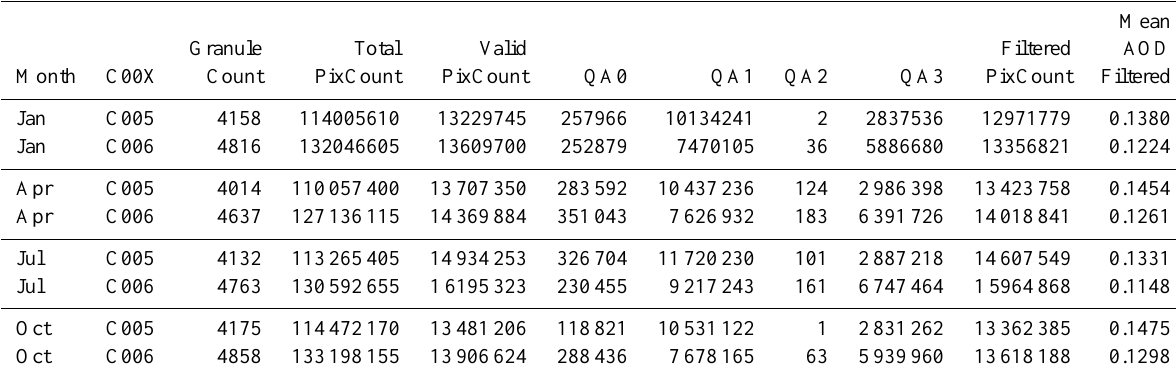
Table 4. C5/C6 comparison of DT-ocean statistics for Aqua; January, April, July and October